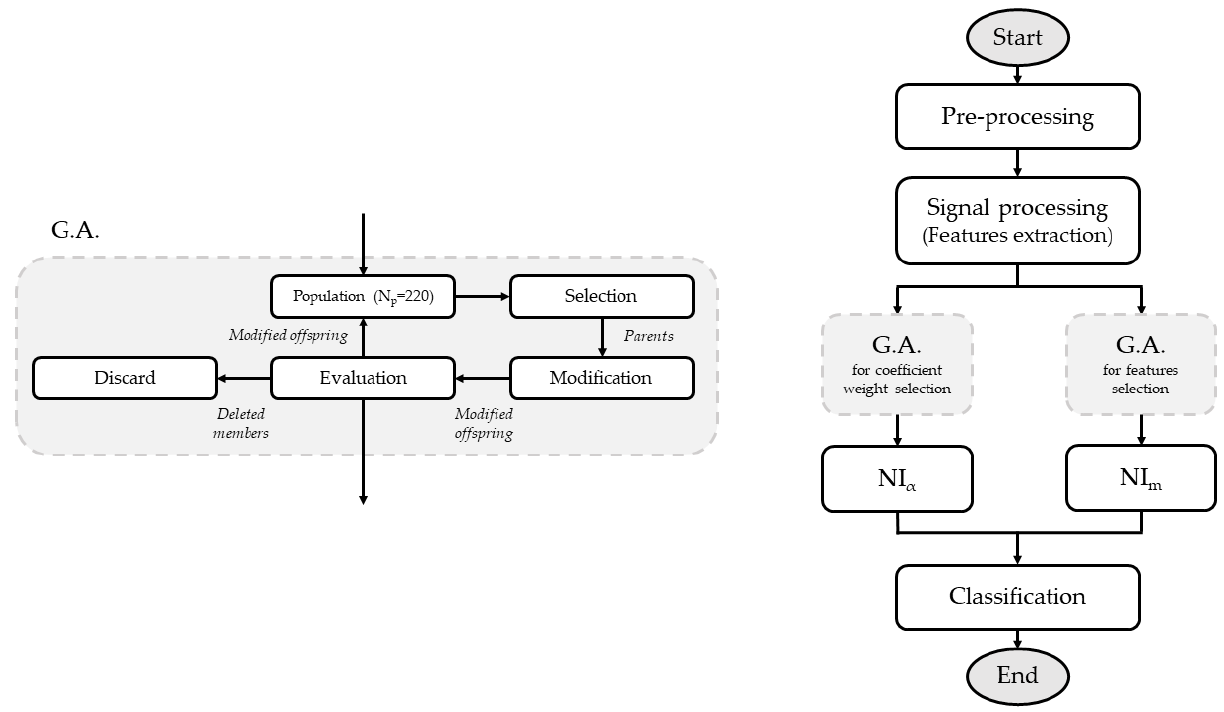
Figure 2. Flowchart summarizing the proposed method with a focus on the GA cycle.